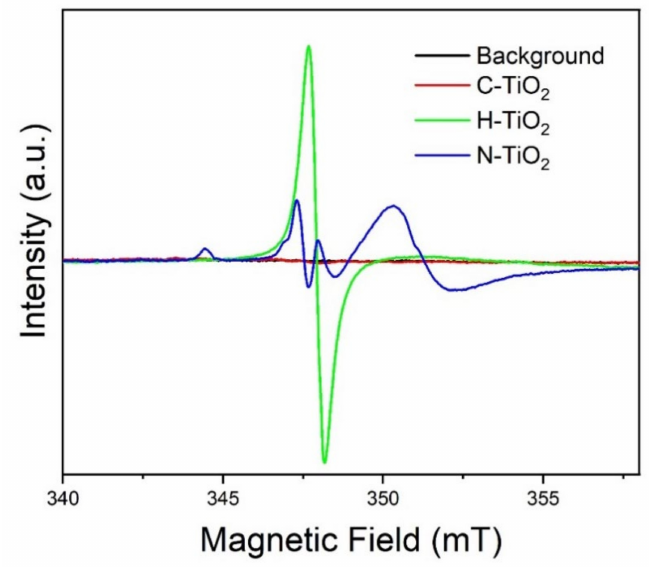
Figure 6. EPR spectra of paramagnetic species in C-TiO 2 , H-TiO 2 and N-TiO 2 . Spectra in this display have not been adjusted for slightly different microwave frequencies or for slightly different sample weights. The frequencies were 9755.2 MHz, 9755.0 MHz, 9753.3 MHz and 9754.3 MHz for background, C-TiO 2 , H-TiO 2 and N-TiO 2 ,